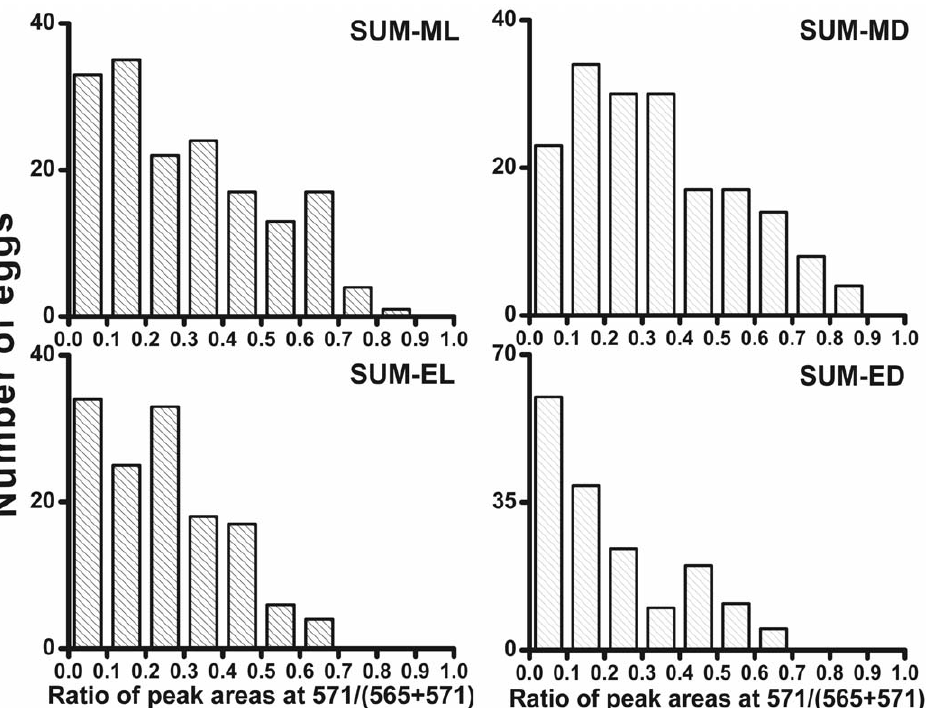
Figure 5. Histograms showing the distributions of labeling levels within the eggs obtained from the fruit flies incubated with 13 C 6 - glucose (during 12 h) at different illumination conditions and at different times during the day/night cycle. ML – flies incubated during day (starting from the morning) at light; MD – flies incubated during day (starting from the morning) at dark; EL – flies incubated during night (starting from the evening) at light; ED – flies incubated during night (starting from the evening) at dark.